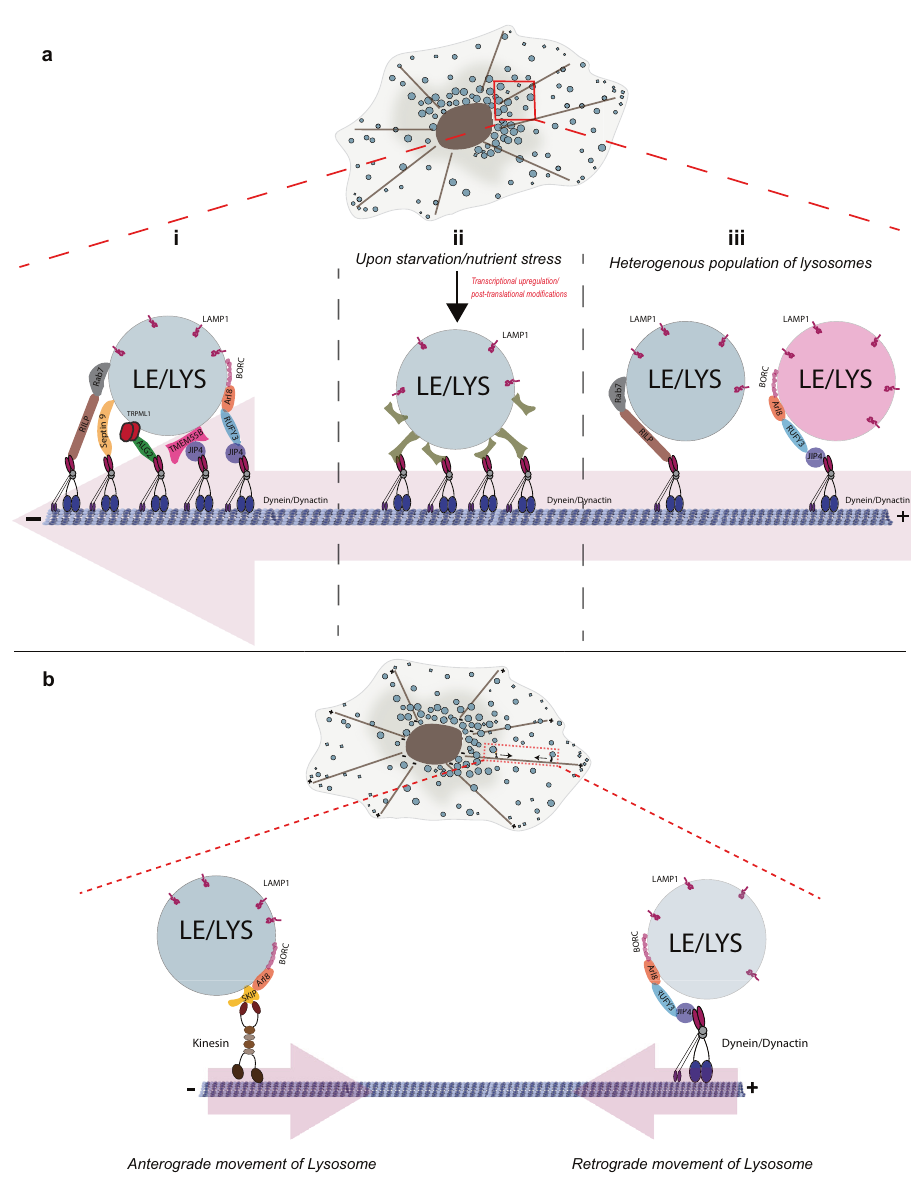
Fig. 9 Schematic representing the role of multiple motor-adaptors in lysosome positioning. a Three distinct hypothetical scenarios to explain the signi fi cance of different lysosomal adapters that engage the dynein-dynactin complex for retrograde transport. ( i ) Multiple adapters may work in concert to recruit enough dynein motors to balance the opposite driving forces exerted by a single kinesin motor. ( ii ) Different adapters may be required under distinct physiological conditions. For instance, during nutrient starvation, expression, and/or recruitment of a particular adapter might increase onto lysosomes. Increased spatial density of lysosomes and autophagosomes in the perinuclear region could enhance their fusion. ( iii ) Different dynein adapters are required for retrograde transport of distinct populations of lysosomes that may differ in their membrane composition. b A model illustrating the opposing motor adapters recruited by Arl8b. Arl8b relieves autoinhibition of SKIP, which in turn recruits and activates the Kinesin-1 motor to promote anterograde motility of lysosomes. As revealed in this study, Arl8b recruits RUFY3 on lysosomes, which then interacts with the JIP4-dynein-dynactin complex to mediate lysosome retrograde EBSS for 2h. After treatment, cells were lysed using ice-cold RIPA buffer sup- then pulsed with BODIPY FL LDL (7.5 µg/mL; Invitrogen) made in starvation plemented with protease inhibitor. An equal amount of lysates were loaded on media for 10min. The cells were washed with 1X PBS and chased in phenol red- SDS-PAGE, transferred to PVDF membrane, and probed for LC3B-II and β - free complete media containing Lysotracker Red DND-99 (100nM) to label tubulin. Densitometry analysis of LC3B-II band intensity normalized to β -tubulin lysosomes. Time-lapse confocal imaging was done at 0, 30, 60, and 120 min of the intensity was done using Fiji software. chase. The colocalization between LDL and Lysotracker at different time periods was measured using the JACoP plugin of Fiji software.